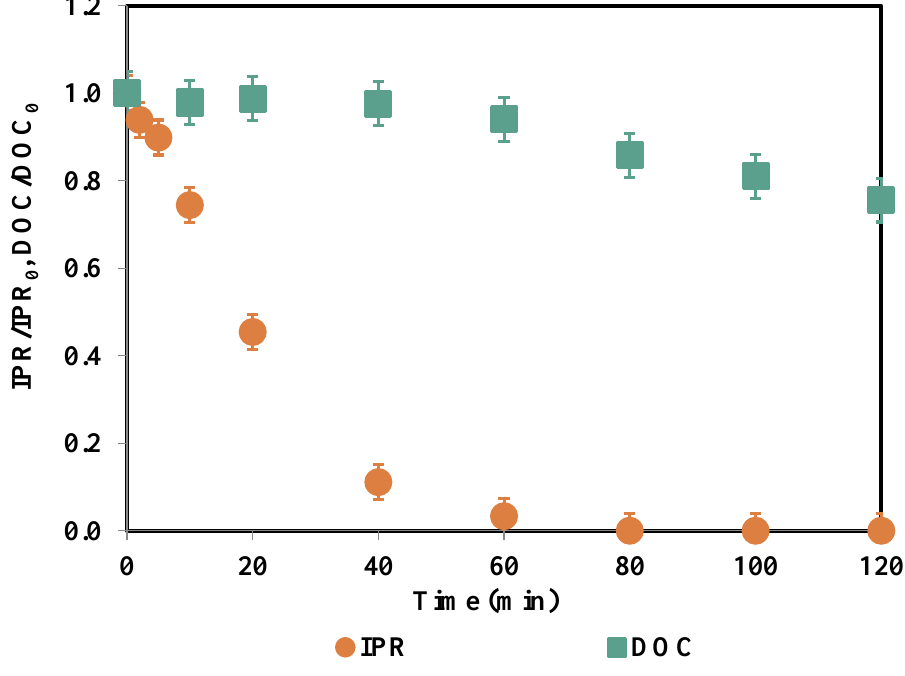
Figure 8. Changes in normalized IPR and DOC during UV-C/PS treatments in SWW. IPR = 2 mg/L; PS = 0.09 mM; DOC = 11.4 mg/L; UV-C intensity = 0.5 W/L; pH = 6.8 (the pH of SWW).